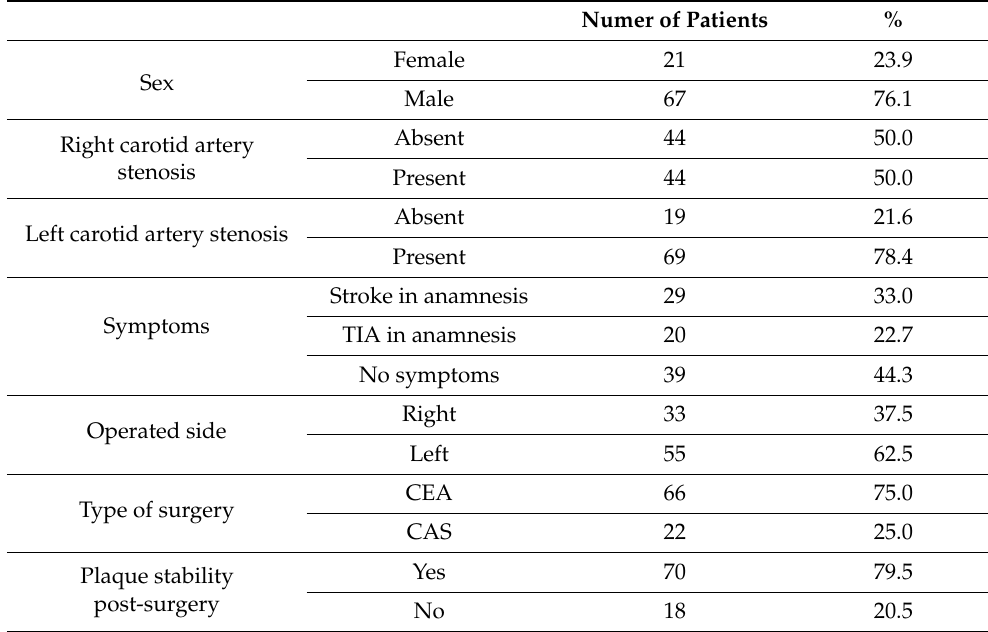
Table 1. Characteristics of parameters in patients.